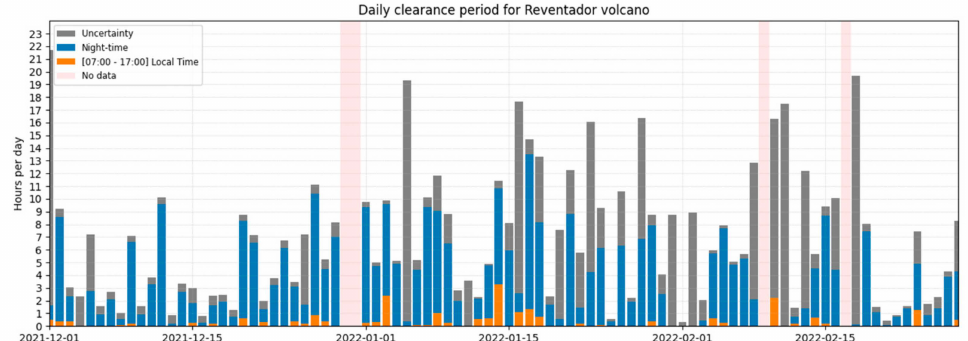
Figure 8. The portion of the day when the volcano is observable by thermal camera (day and night) is represented by stacked blue bars, while the “working” portion of the day (07h00 to 17h00, local time) when the volcano is observable is represented with orange bars. The uncertainty, in grey, depends on the quantity of images that are corrupted or the instrument did not acquire for any